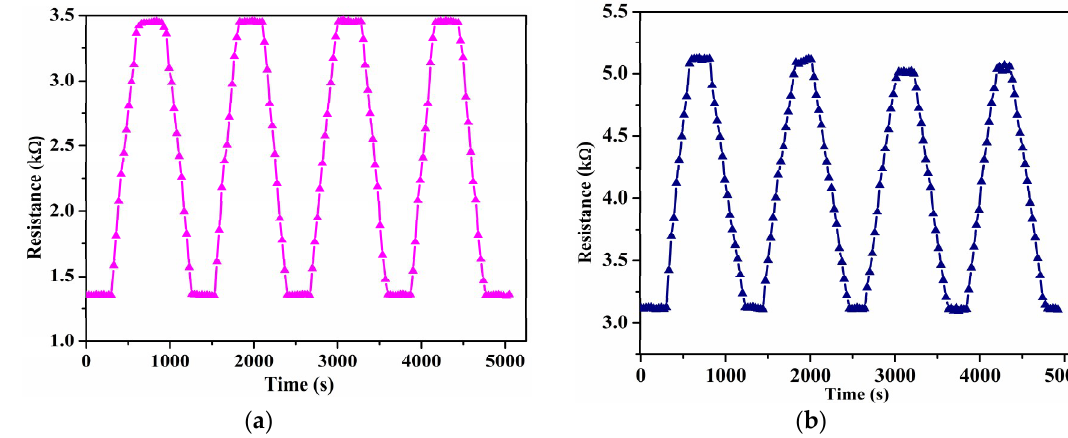
Figure 4. ( a ) Repeatability measurement over four humidity cycles for the suspended CNTs, and ( b ) for the non-suspended CNTs.